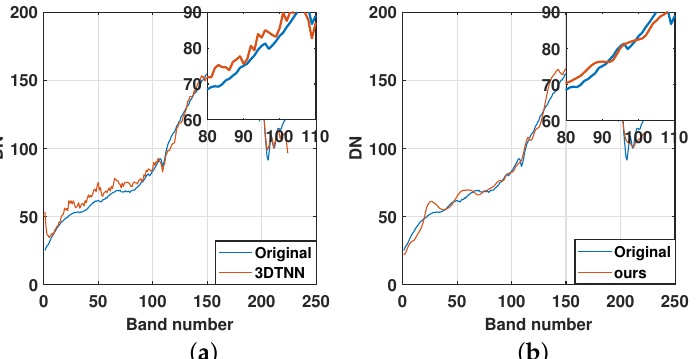
Figure 12. The reflectance of pixel (100,30) in the dataset-2 denoised by ( a ) 3DTNN and ( b ) ours under noise case 3. Table 4. The value of quantitative indices in the